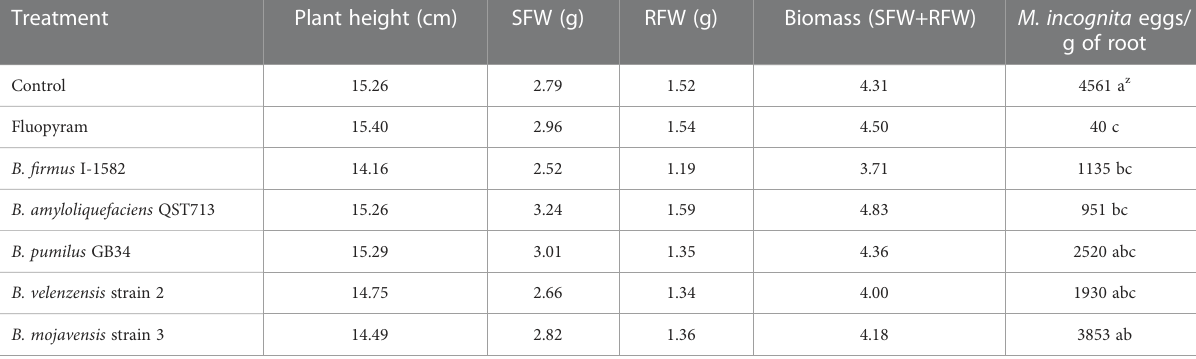
TABLE 2 Greenhouse in planta test to evaluate fi ve Bacillus spp. as biological control agents of Meloidogyne incognita on cotton as measured by plant height, shoot fresh weight (SFW), root fresh weight (RFW), biomass and M. incognita eggs/gram of root 30 days after inoculation y . Treatment